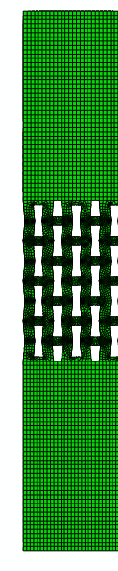
Figure 6. FE model of Specimen H40A85R1.